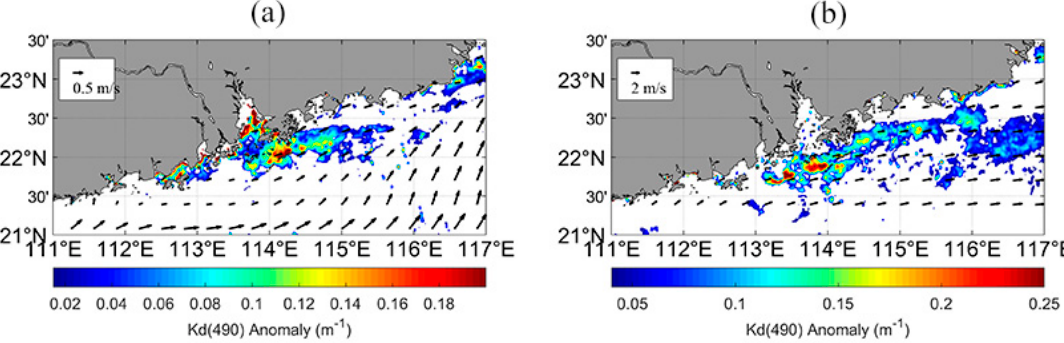
Figure 11. K d (490) and wind field anomalies during summer in ( a ) 2007 and ( b ) 2015 .